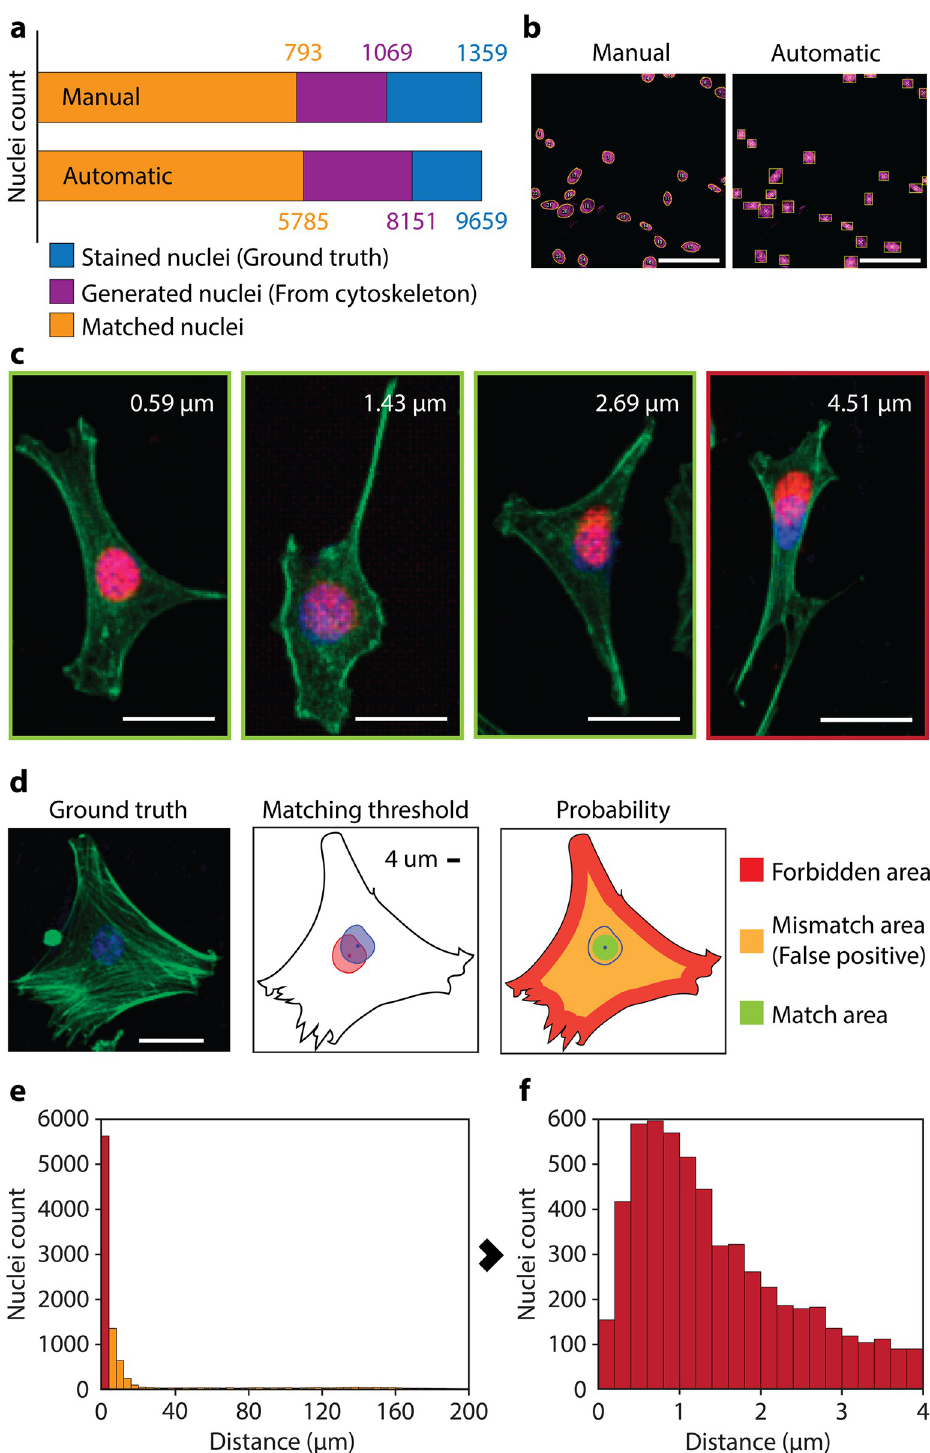
Fig 3. Positioning of nuclei generated from arrangements of actin filaments. a, Results of the identification and matching of real and generated nuclei by an automatic counting of the whole generated dataset and by manual counting of a subset of images. Stained nuclei refer to those recorded directly using fluorescent microscopy. Generated nuclei are those produced by the neural network using actin filament arrangements. Matched nuclei are those generated at less than 4 μ m of its real counterpart. b, Manual (left) and automatic (right) processing of the same image.